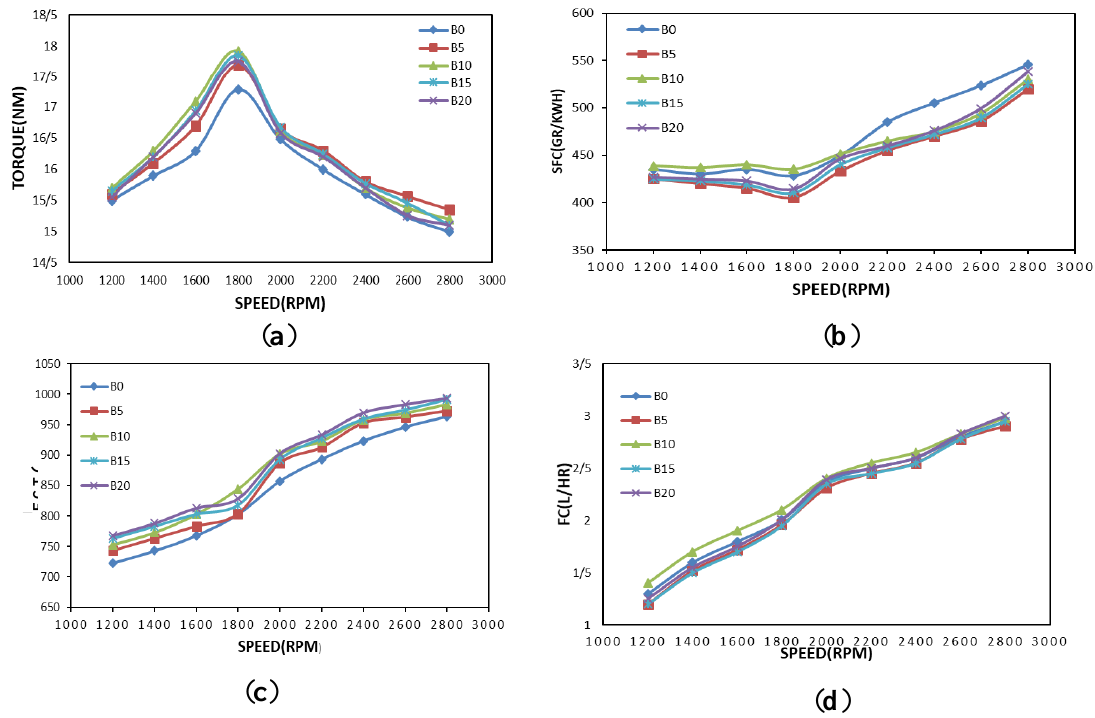
Figure 12. Prediction of torque ( a ), EGT ( b ), FC ( c ) and SFC ( d ) by ANN at various engine speeds.